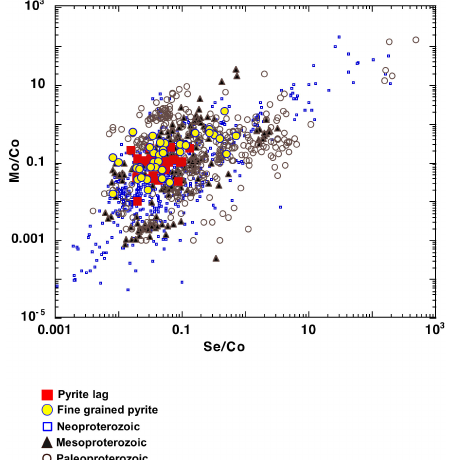
Pyrite lag Fine grained pyrite Phanerozoic Archean Figure 12. Comparison of Se/Co vs Mo/Co in the Bijaigarh Black Shale unit with Archean and Phanerozoic sedimentary pyrites [16,18].